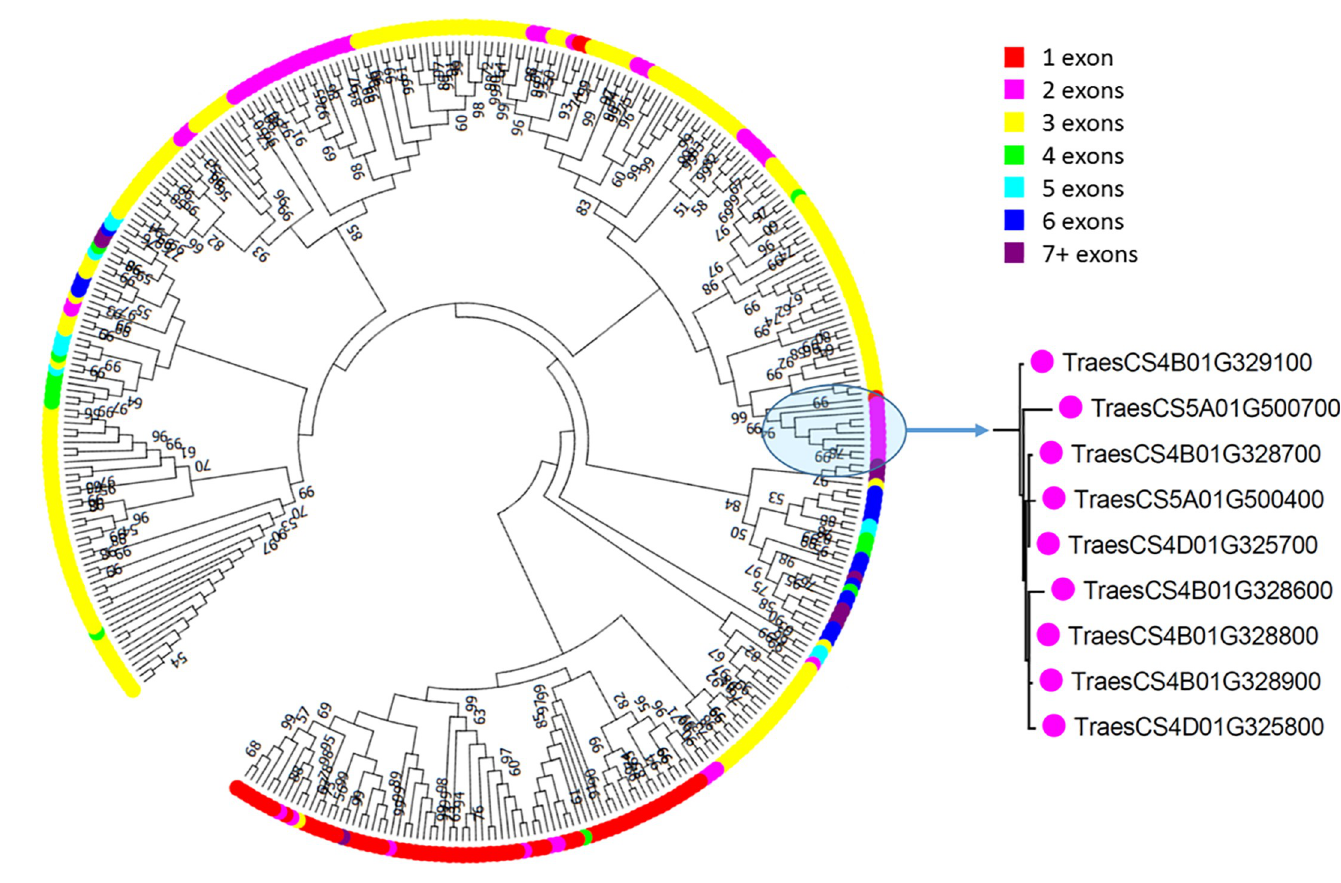
Fig 1. Maximum likelihood phylogeny of the 361 common complete protein sequences. The zoom focused on the clade studied as a case of duplication. Colors indicate the number of exons in each sequence.